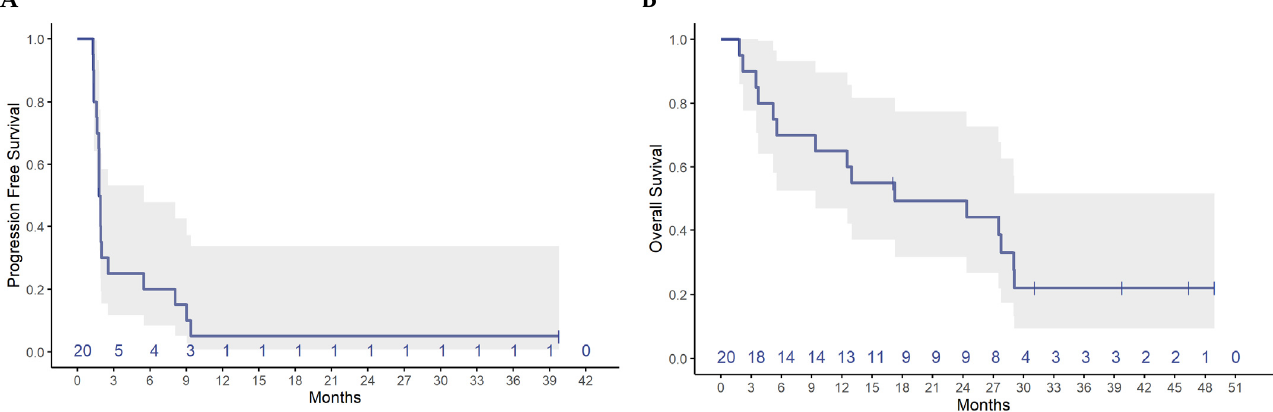
Figure 2. Progression-free survival and overall survival (N = 20). ( A ) Median PFS was 1.8 months (95% CI 1.6, 2.6), and ( B ) median OS was 17.2 months (95% CI 9.4, NA). Numbers above x-axis refer to number of patients.